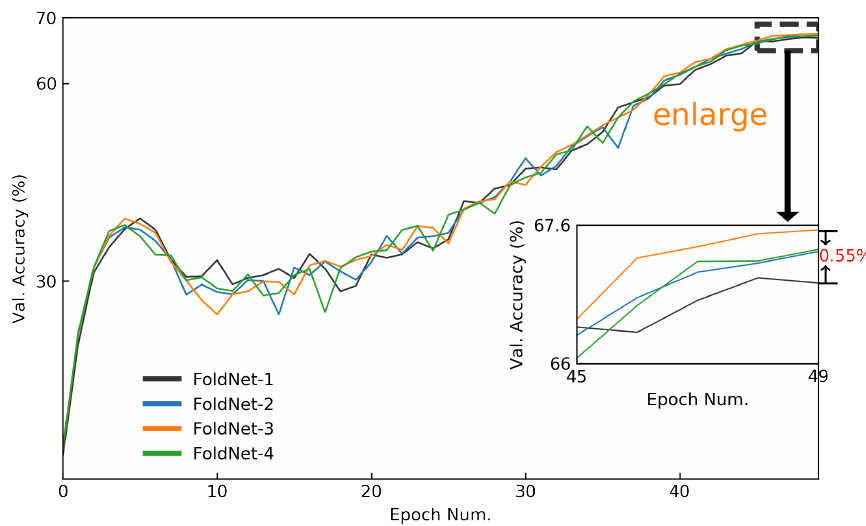
Figure 9. Validation-accuracy curves of FoldNet for Tiny ImageNet dataset when hidden dimension h = 256 and network depth n = 32. The validation-accuracy curves of the last five epochs are enlarged to compare the accuracies of FoldNet- d more